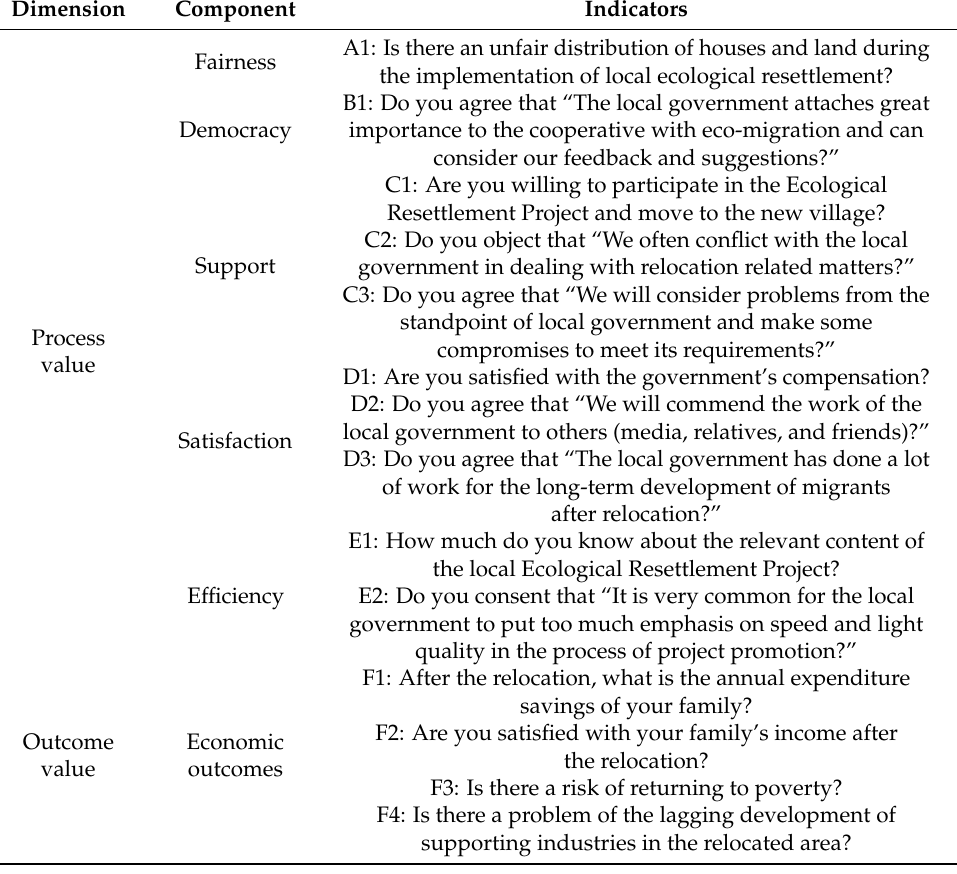
Table 2. Index system to evaluate the performance of Ecological Resettlement Project.